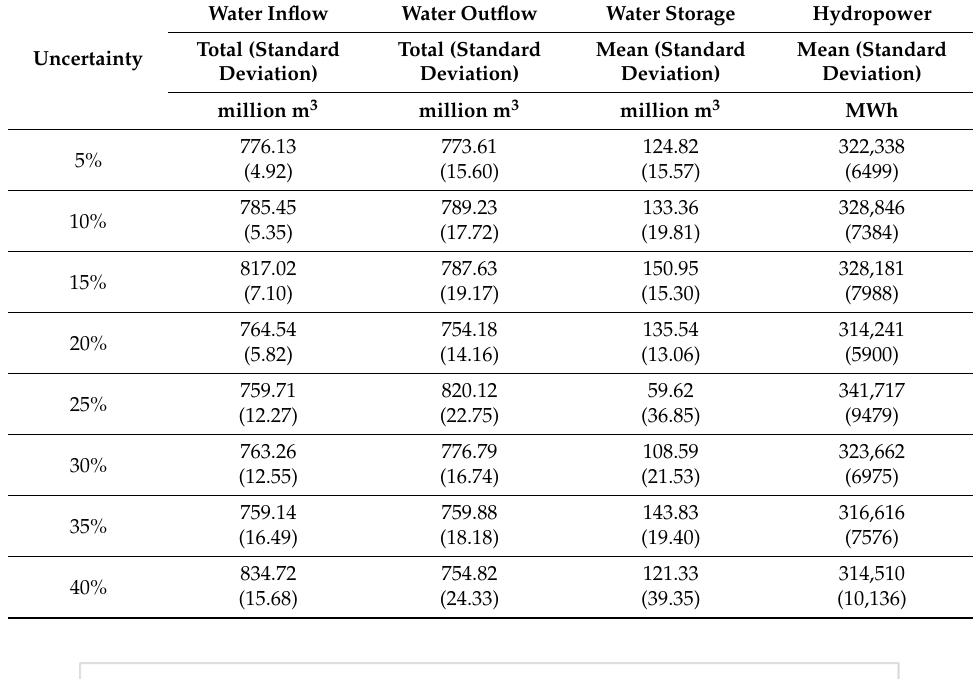
Table 1. Uncertain simulation of water inflow, outflow, storage, and hydropower of the Shihmen Reservoir.